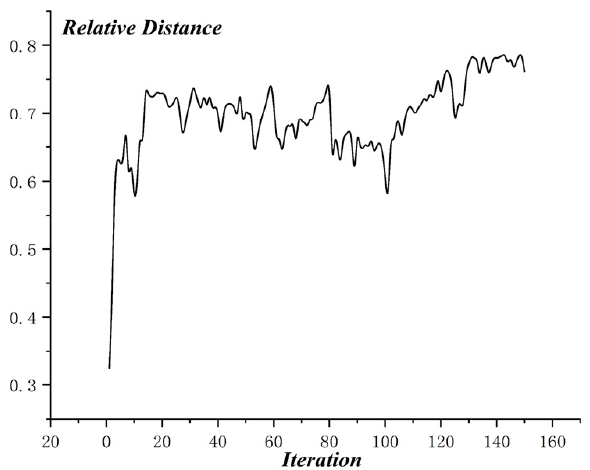
Figure 15. Relative distance of MO-GWO.